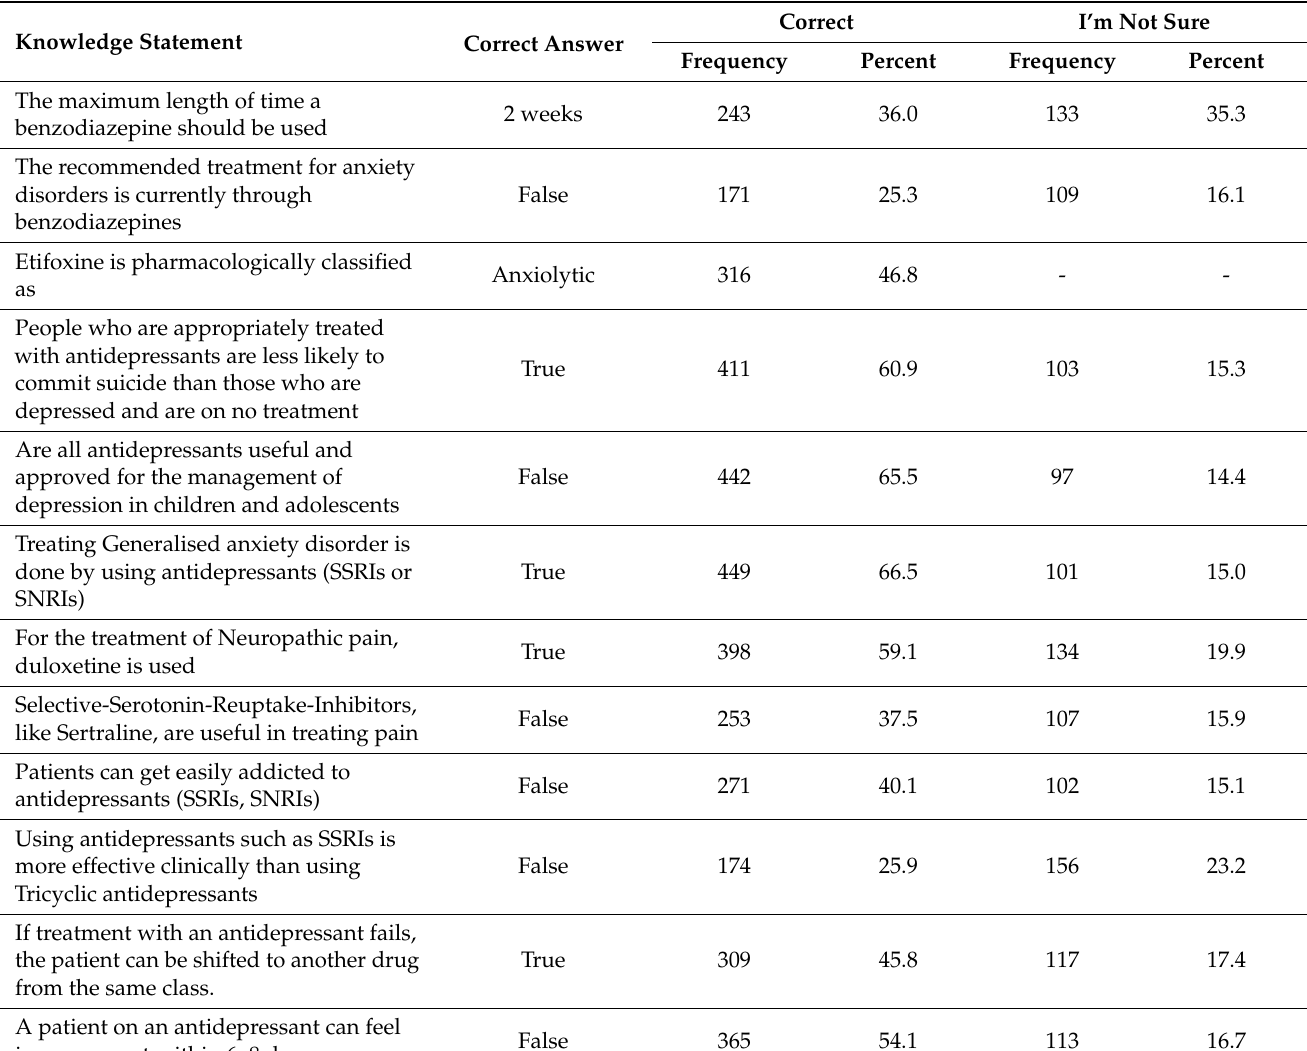
Table 3. The distribution of the actual knowledge answers of the